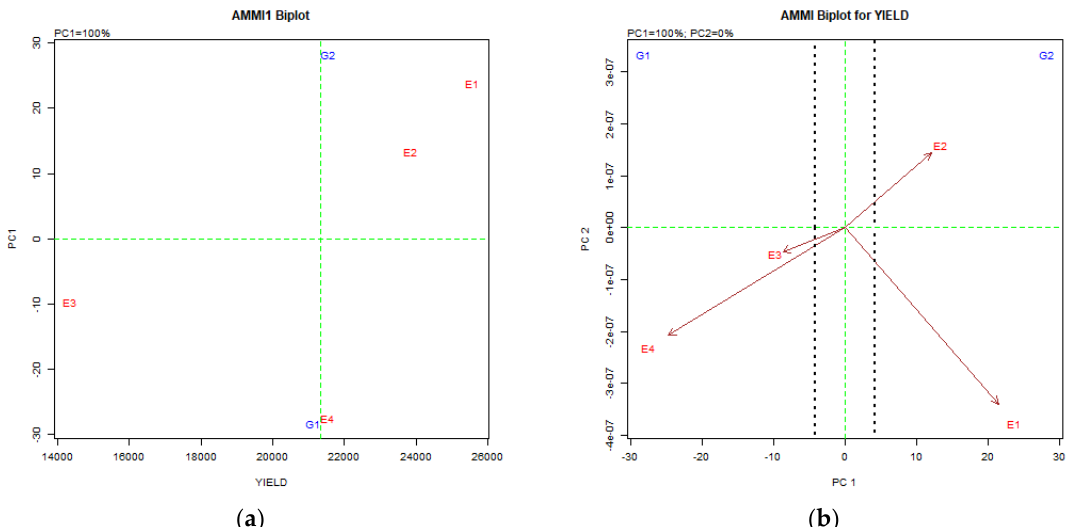
Figure 2. AMMI Biplot for genotypes (G) and years (E) for yield and separation of genotypes for yield favoring years. ( a ) The contribution on variance of the factor of years in the treatment of yield (E) the year E2 and E3 gives a small amount on variance whereas E1 and E4 are the most diverse years producing variance over the genotypes G1 and G2 for the variable of yield. ( b ) The deviation of years from the ideal year, E3 has the smaller deviation of the ideal year on yield; the favorable years for G1 are the E3 and E4 whereas the favorable years for G2 are the E1 and E2.